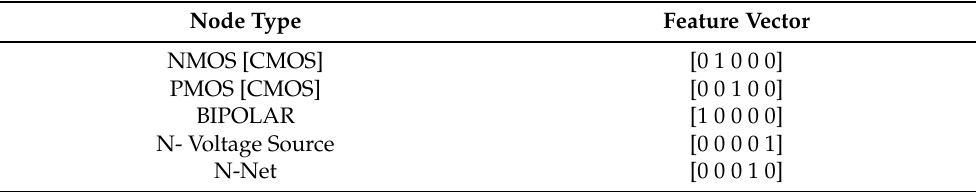
Table 3. Five unique types of elements are considered for this classification